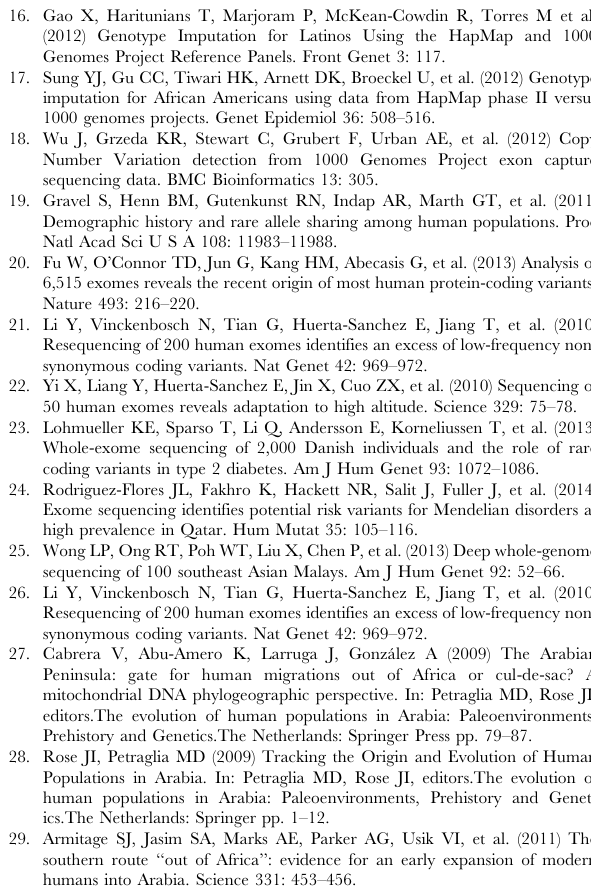
Dataset S3 Data set of identified novel non-exomic SNPs from the UW data set of the two whole genomes. The data is presented in Variant Call Format (VCF). (GZ) Dataset S4 Data set of all identified non-exomic indels (known and novel) from the UW data set of the two whole genomes. The data is presented in Variant Call Format